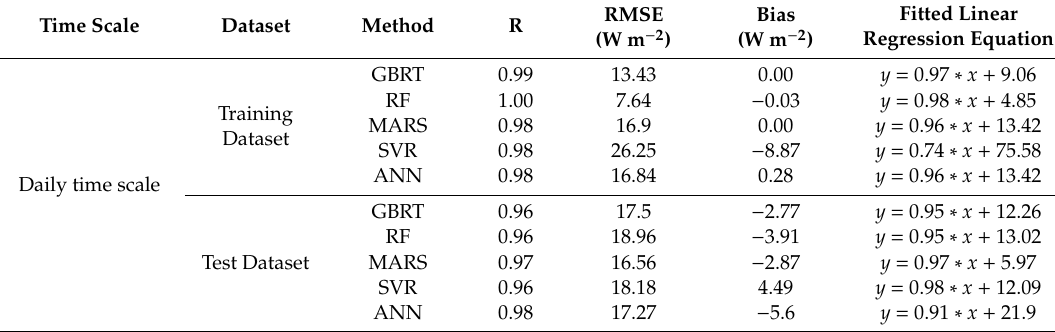
Table 2. Statistical parameters for the training and test datasets of five methods on both daily and monthly time